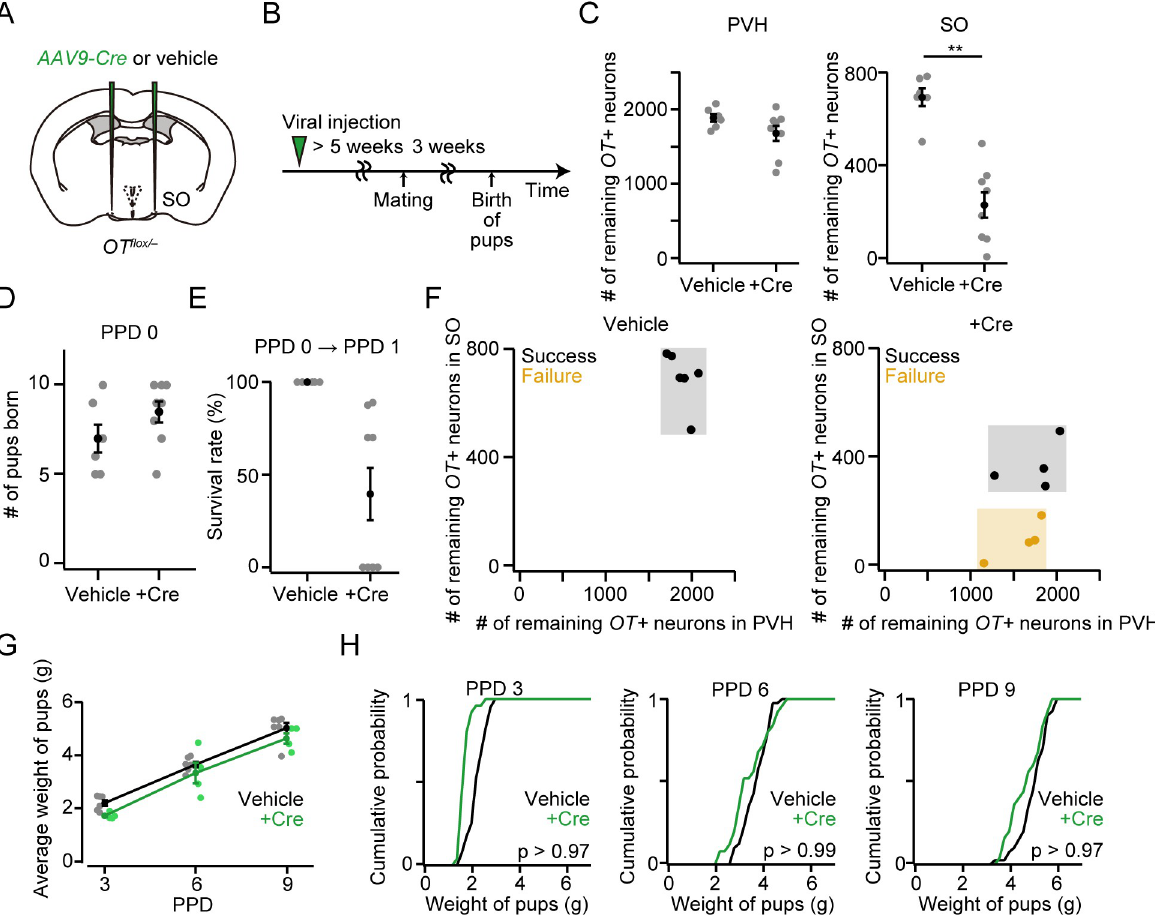
Fig 7. OT expression in the SO is necessary for the survival of pups. (A) Schematic of the viral injection. AAV-Cre or vehicle was injected into the bilateral SO. (B) Schematic of the timeline of the experiment. (C) Number of remaining OT + neurons in the PVH (left) or SO (right). �� p < 0.01, two-sided Mann–Whitney U- test. n = 6 and 8 mothers for vehicle and +Cre, respectively. (D) The number of pups born was not statistically different (p > 0.21, two-sided Mann–Whitney U- test). No dead pups were found. n = 6 and 8 mothers for vehicle and +Cre, respectively. (E) Survival rate of pups at PPD 1. n = 6 and 8 mothers for vehicle and +Cre, respectively. (F) Relationship between the success (black dots) or failure (orange dots) of raising pups at PPD 1 and the number of remaining OT+ neurons in the PVH (x-axis) or SO (y-axis). Data from the same mice shown in C. (G) Average weight of pups per dam. Mothers in which all pups were dead at PPD 1 were excluded from +Cre. No statistical difference was found in vehicle and +Cre (two-way ANOVA with repeated measurements). n = 6 and 4 for vehicle and +Cre, respectively. (H) Cumulative probability of weight of pups in PPD 3, PPD 6, and PPD 9. Mothers in which all pups were dead at PPD 1 were excluded in +Cre. The p-value is shown in the panel (Kolmogorov–Smirnov test). n = 40 and 25 pups from six and four mothers for vehicle and +Cre, respectively. Error bars, standard error of the